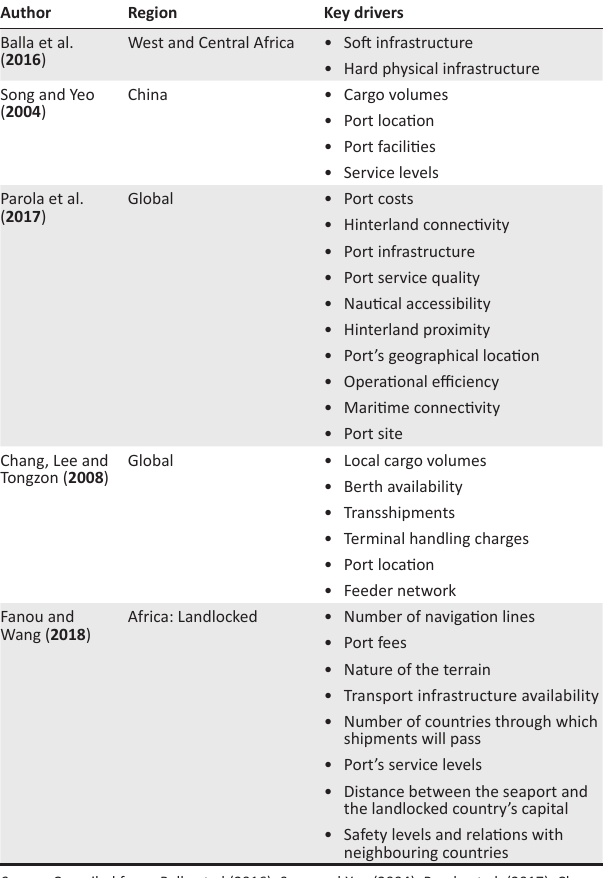
TABLE 1: Sea port selection criteria.